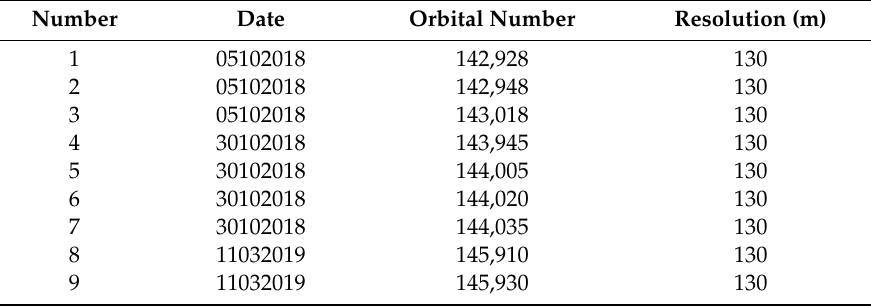
Figure 2. Luojia I NTL images distribution. Table 1. List of Luojia I Night-Time Light (NTL) images